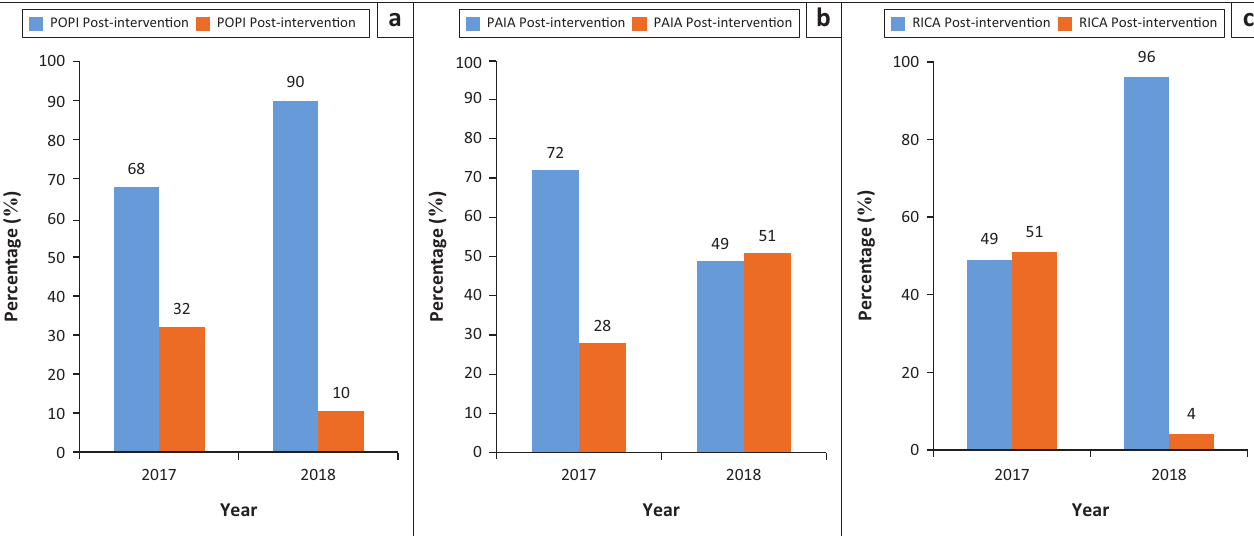
b ca POPI Post-interven(cid:31)on PAIA Post-interven(cid:31)on PAIA Post-interven(cid:31)on RICA Post-interven(cid:31)on RICA